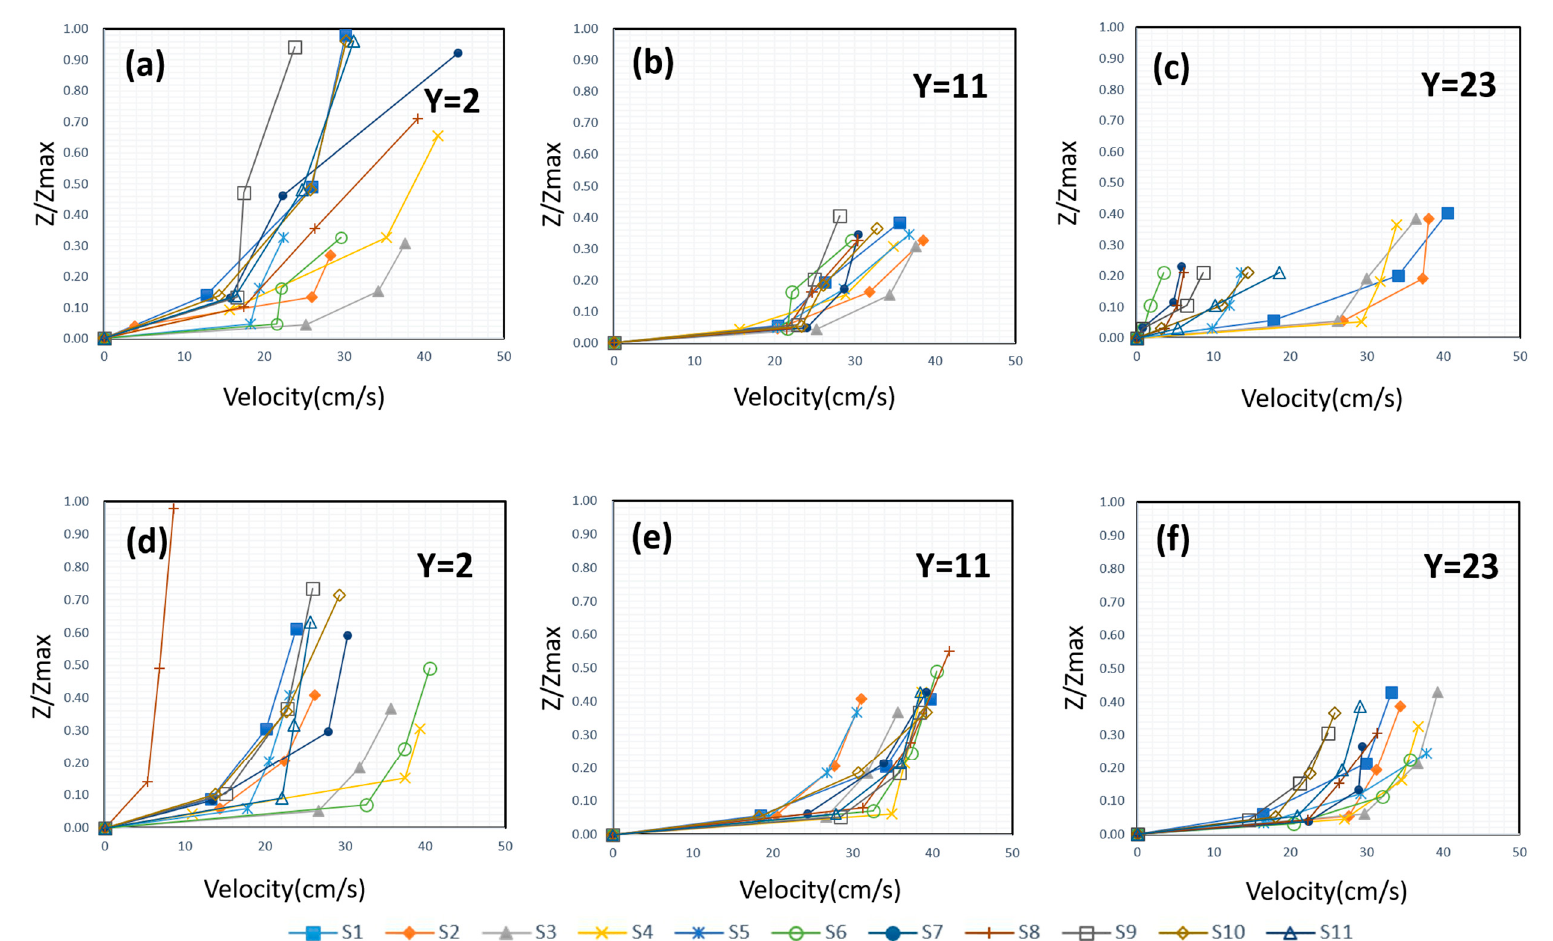
Figure 8. The sectional vertical velocity and its dimensionless scouring with ( a )–( c ) non-spur protection, and ( d )–( f ) spur protection in the flood return period of 20 years.